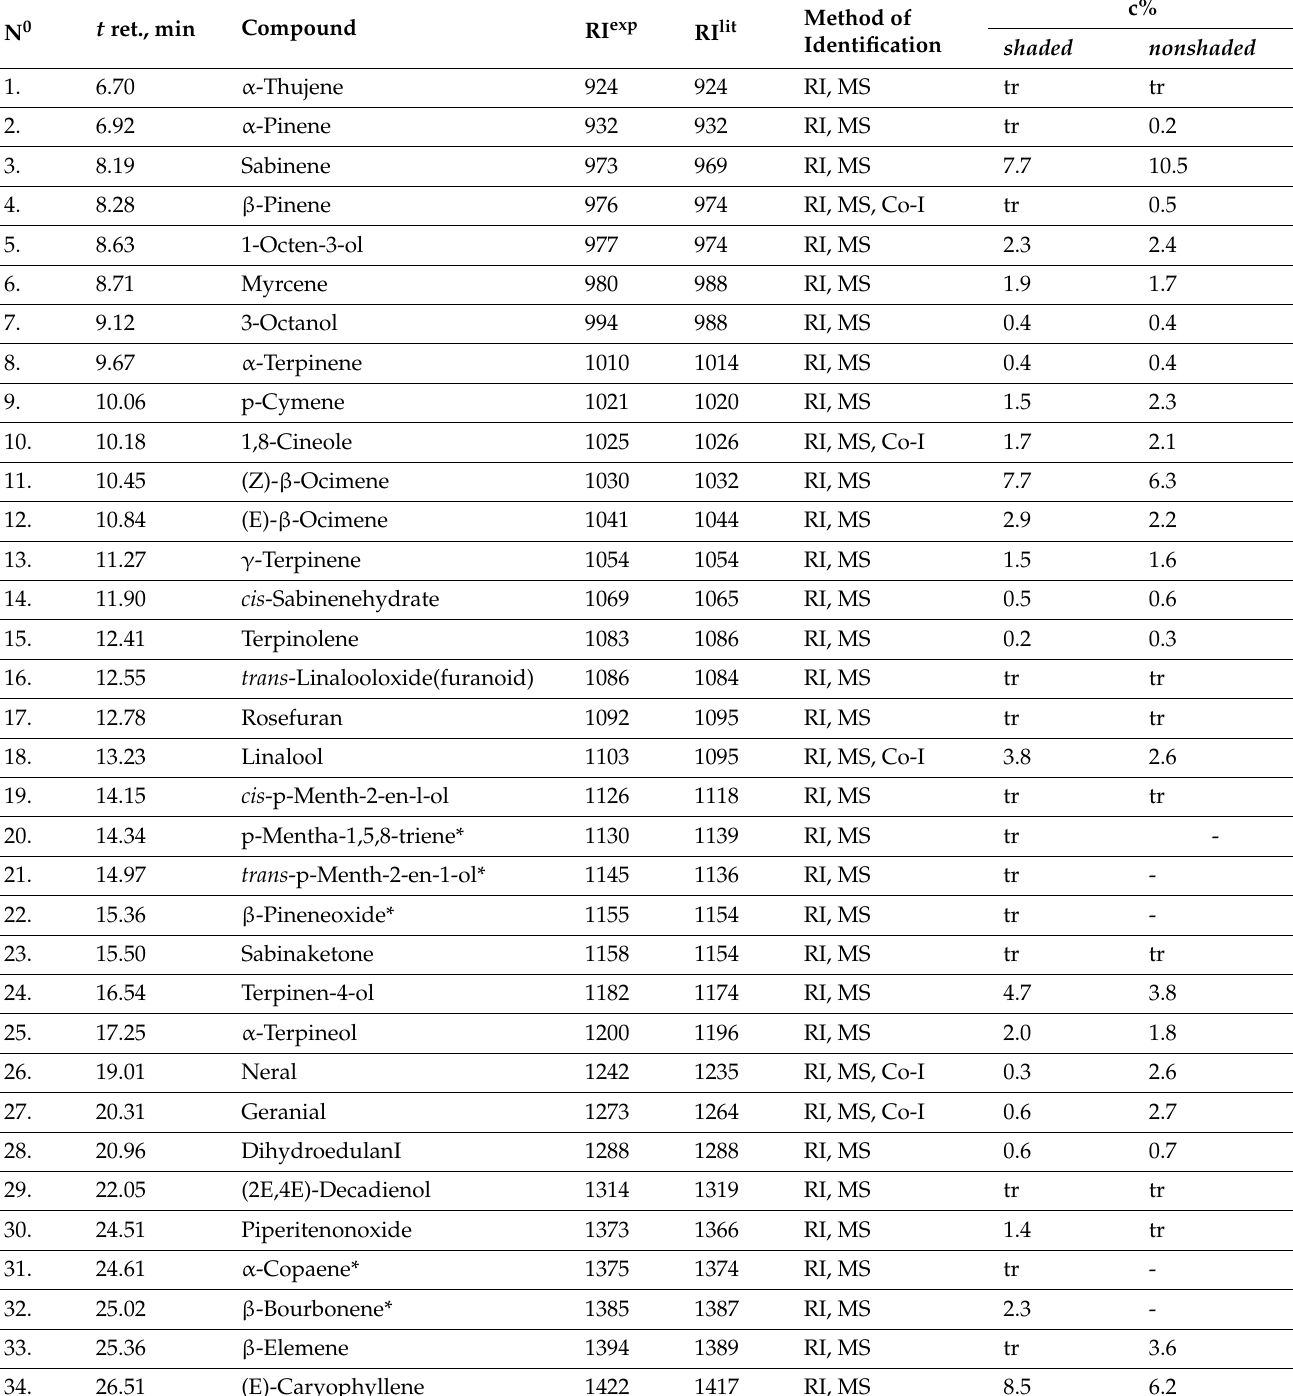
Table 3. Chemical composition of essential oil isolated from shaded and nonshaded oregano (stem,